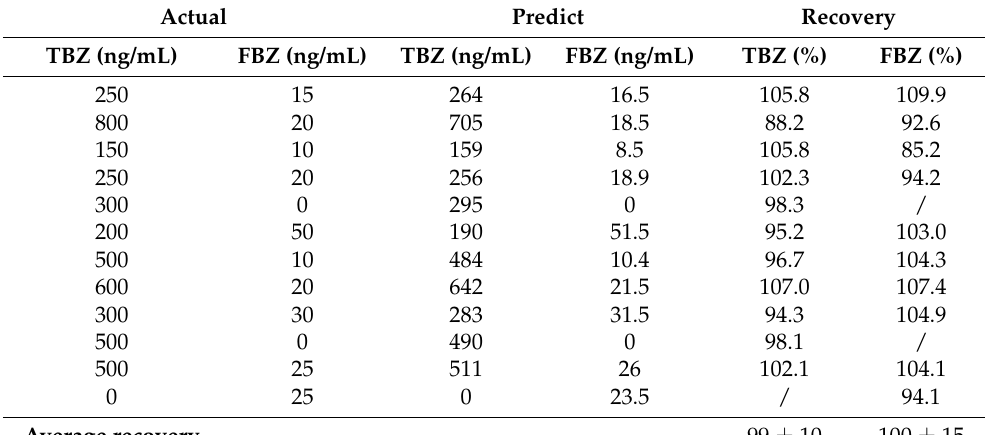
Table 3. Predicted results of the developed prediction model for the manually formulated test set. Actual